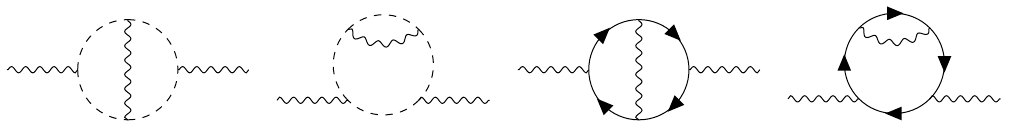
Figure 11. Set of two-loop diagrams contributing to β g which is affected by substitution rules for the semi-simple gauge group. We follow a standard convention where the solid line, the dotted line and the wavy line correspond to the fermions, the scalars and the gluons